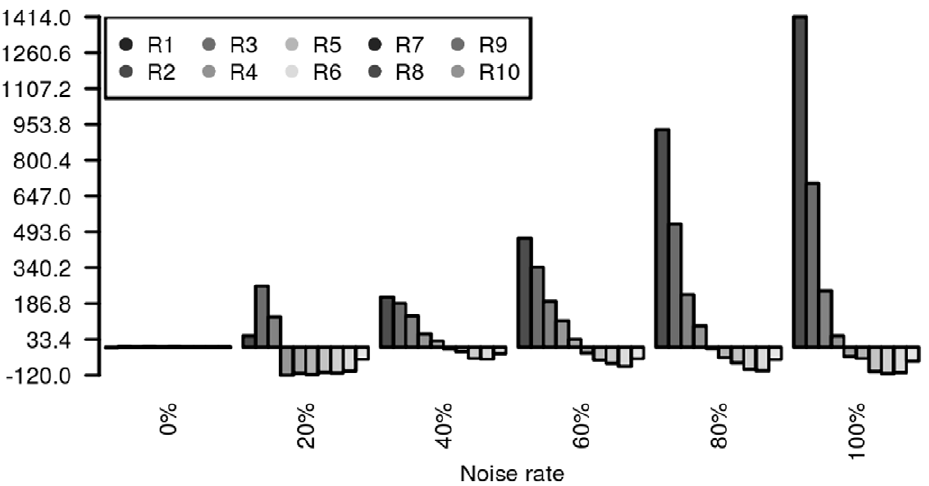
Figure 1. The distribution of prediction errors for Toy B data using SIMA (mass resolution 0.0071 Daltons). The horizontal axis represents the noise rate added to features in Toy B. The vertical axis represents either missing hypothesis (MH) or false prediction (FP). Each histogram group comprises ten bars representing ten types of consensuses (ten different number of features). The first bar represents the error between the number of expected singletons and the number of predicted singletons. The last bar represents the error between the number of true consensuses of size ten and the number of predicted consensuses of size ten. When FP occurs, we see a positive bar. When MH occurs, we observe a negative value.